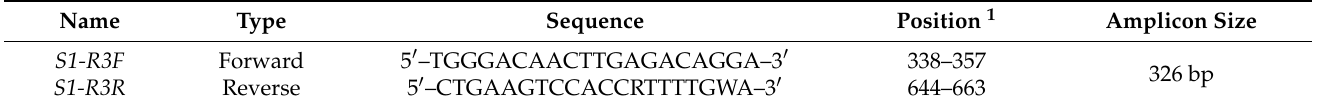
Table 3. Primers used for PCR